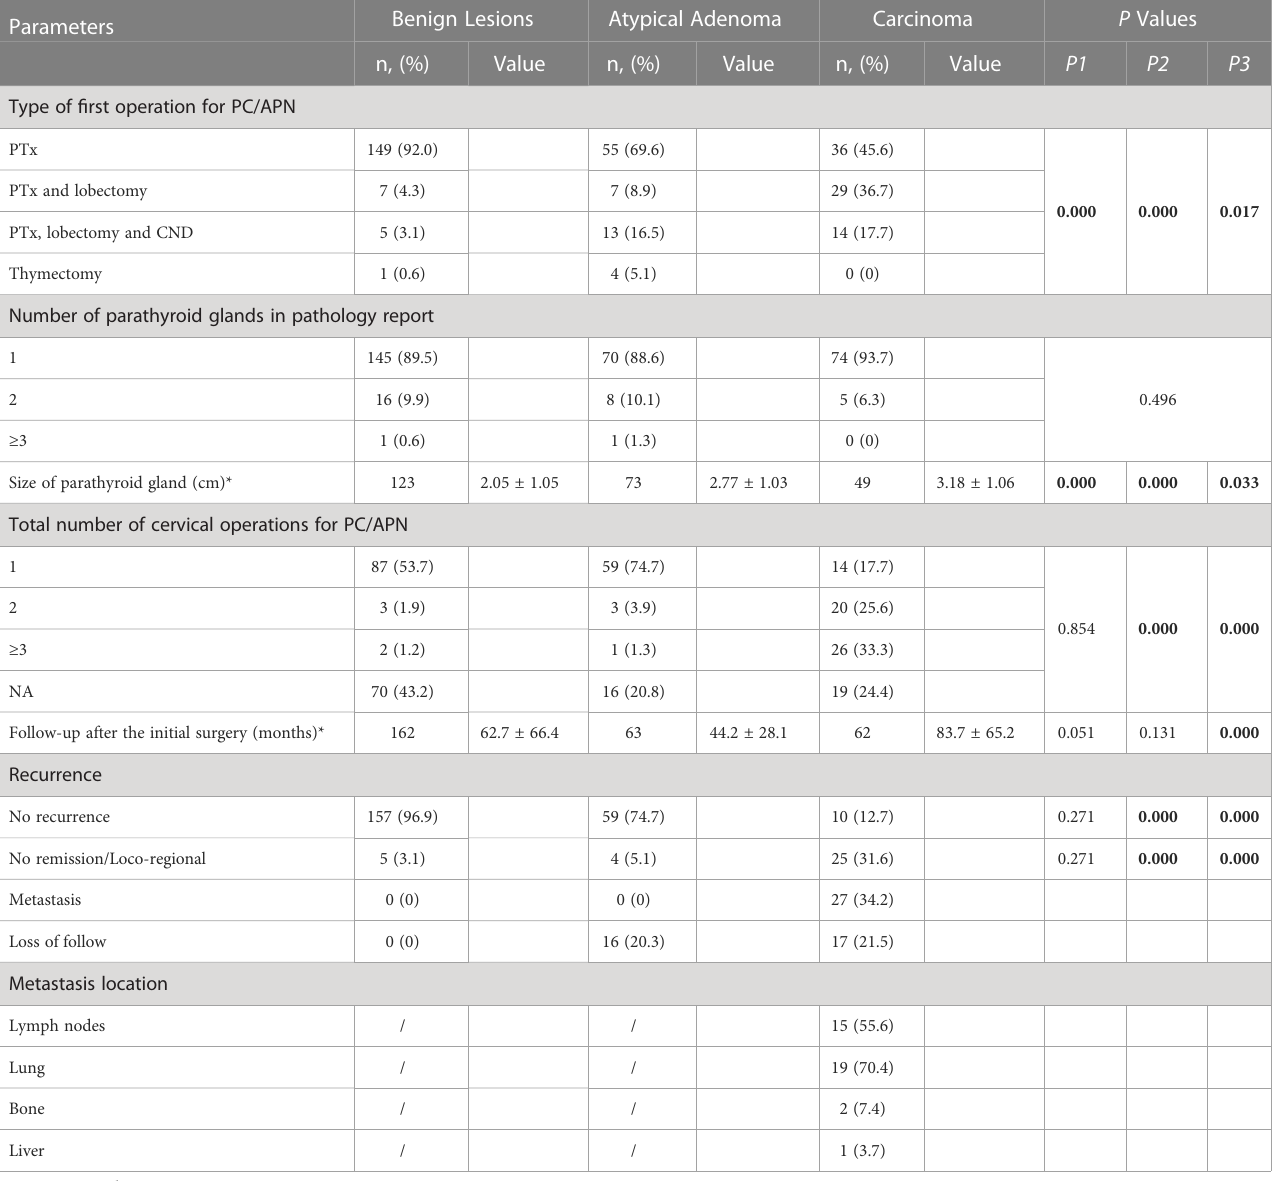
TABLE 2 Surgery-related variables and outcomes of patients with pathologically con fi rmed primary